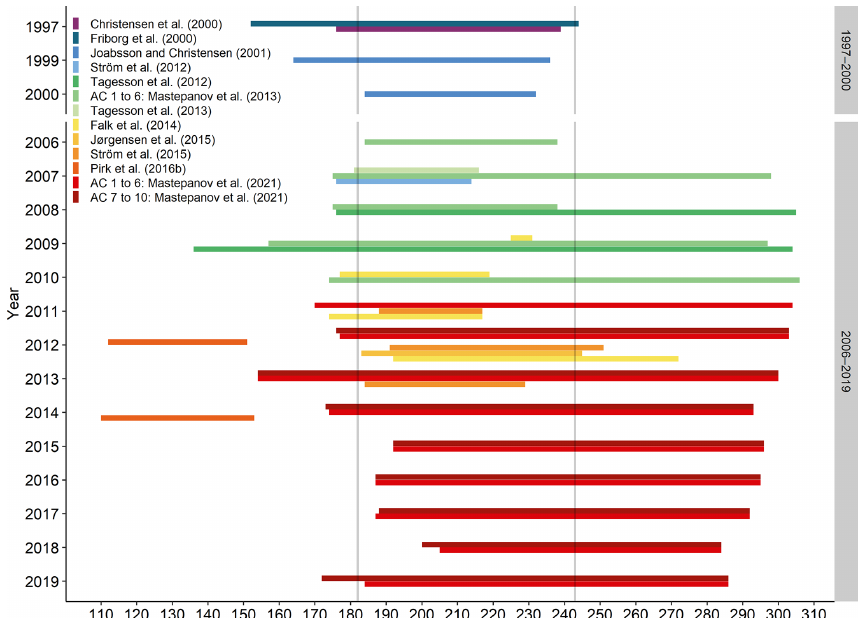
Figure 2. Timeline of methane measurement campaigns and monitoring in individual years, shown as the day of year (DOY). Colors show different publications, and the two vertical gray bars show 1 July and 31 August in non-leap years. Please note that the years 2001–2005 are left out, as no published studies focusing on methane fluxes in undisturbed areas were made in this period.